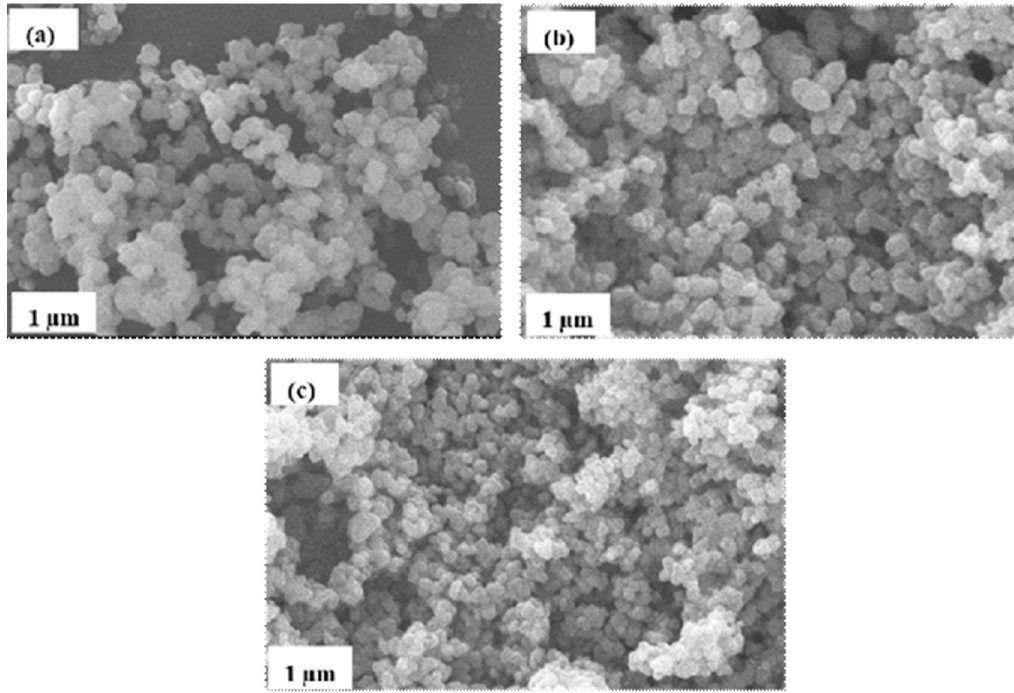
Figure 2. Scanning electron microscopy (SEM) micrographs of ( a ) bare-TiO 2 , ( b ) 20N–TiO 2 -raw and ( c ) 20N–TiO 2 calcined at 300 °C.